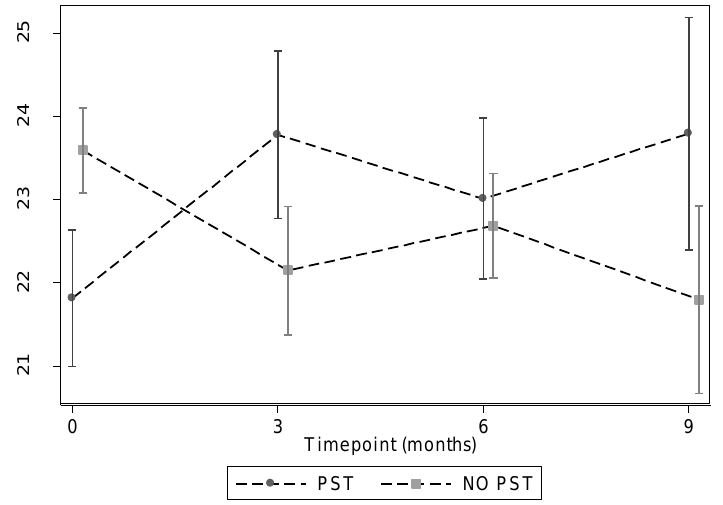
Figure 2. Mean Rasch WEMBS scores at each time point with error bars representing standard errors. Graphs broken down by treatment group.